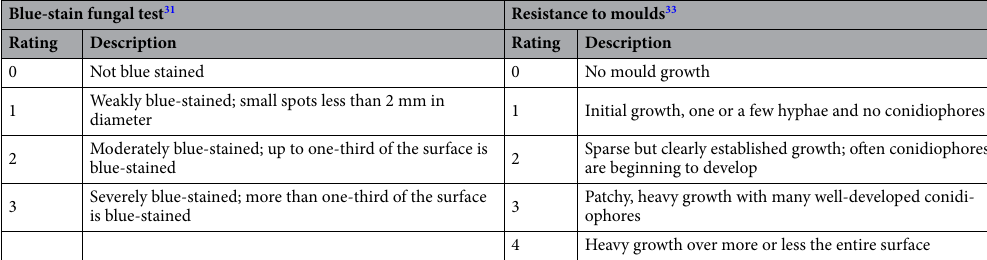
Table 1. Ranking system for determination of the resistance to blue-stain fungi and moulds.